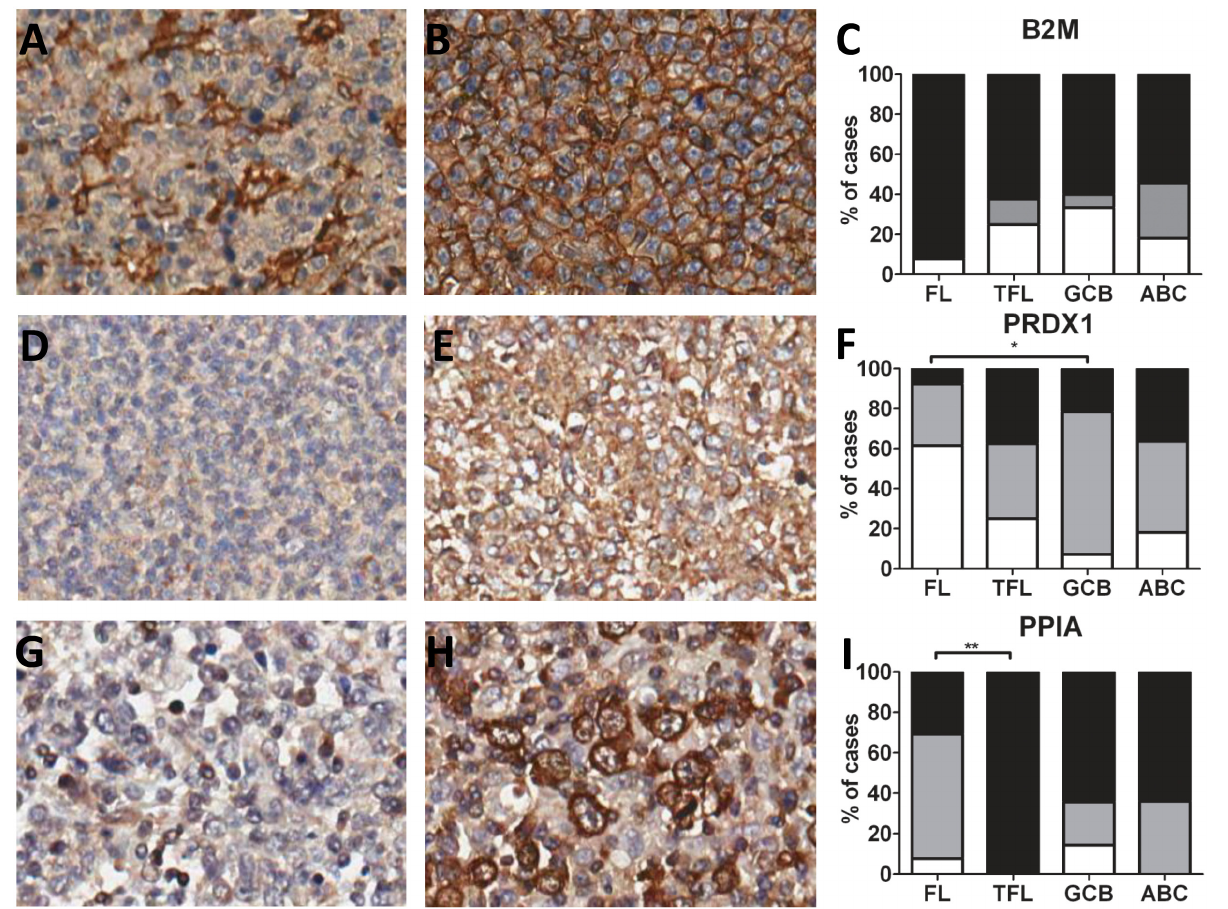
Fig 3. Immunohistochemistry staining of B2M, PRDX1 and PPIA. (A-C) B2M, (D-F) PRDX1, (G-I) PPIA. (A, D, G) negative cases, (B, E, H) positive cases. (C, F, I) Percentage of positive cases in different types of NHLs. Black bar indicates positive staining; grey bar indicates cytoplasmic staining for B2M and weak staining for PRDX1 and PPIA; white bar indicates negative staining. Chi-square test were performed to determine the differences in the B2M, PRDX1, and PPIA staining between the NHL subtypes ( * : p < 0.05; ** : p < 0.01).